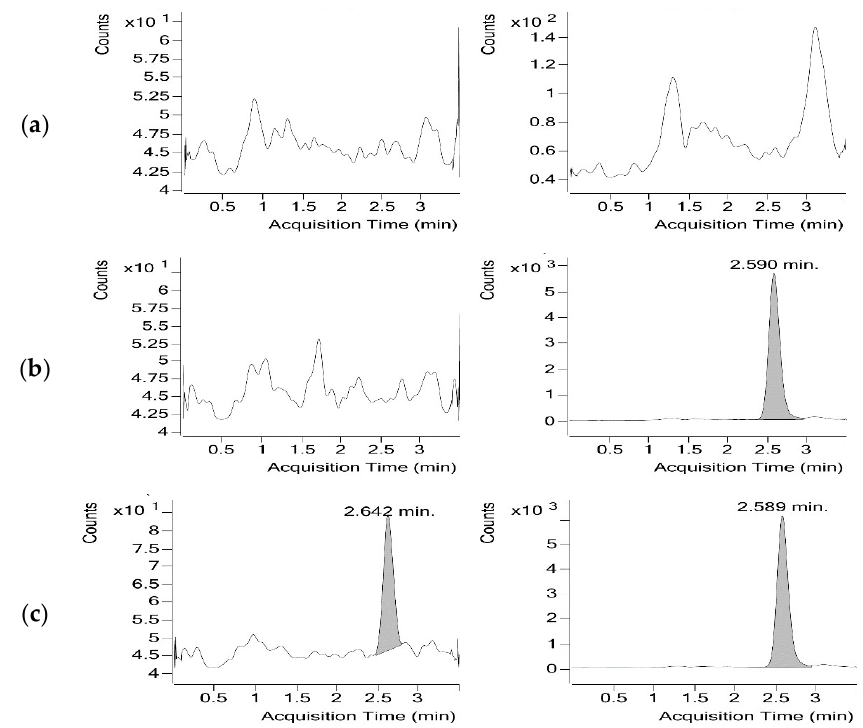
Figure 3. Multiple reaction monitoring (MRM) ion chromatograms of ( a ) A blank plasma sample. ( b ) A spiked plasma sample containing 1782 ng/mL folic acid-d4 (I.S.) tR = 2.590 min. ( c ) A spiked plasma sample containing 13.17 ng/mL folic acid (LLOQ) tR = 2.642 min and 1782 ng/mL folic acid-d4 (I.S.) tR = 2.589 min.